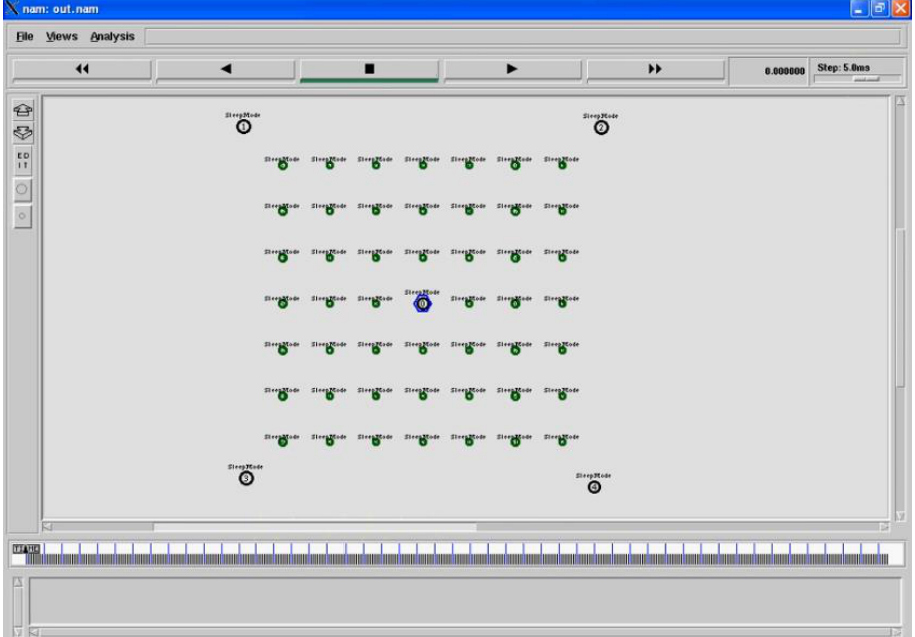
Figure 4. Network Grid active mode with nodes initial states